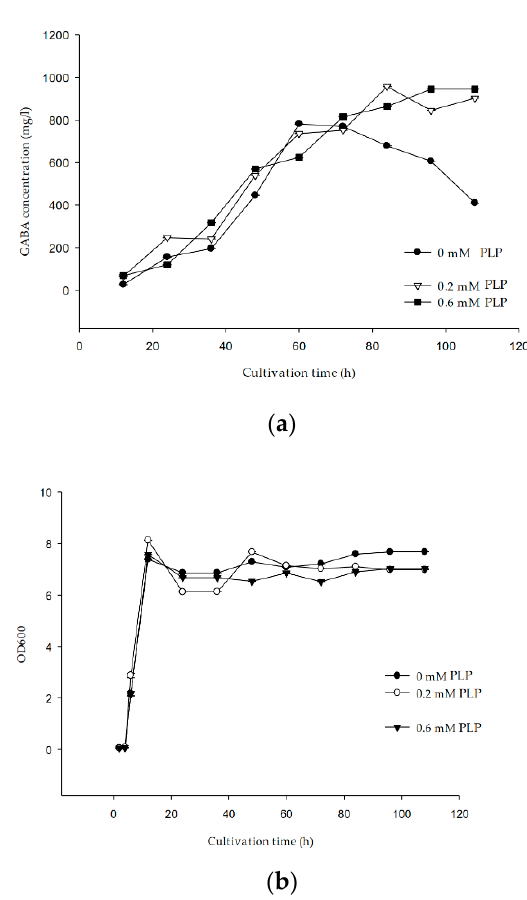
Figure 3. Effect of pyridoxal 5’-phosphate (PLP) on ( a ) GABA production and ( b ) cell growth during the cultivation of L. plantarum FNCC 260. The MRS medium were supplemented with 118 mM MSG and PLP at concentrations 0, 0.2 mM and 0.6 mM. The strain was incubated at 37 °C for 108 h. Data expressed as means ±SD with SD less than 5%. The experiments were conducted at least in duplicates.